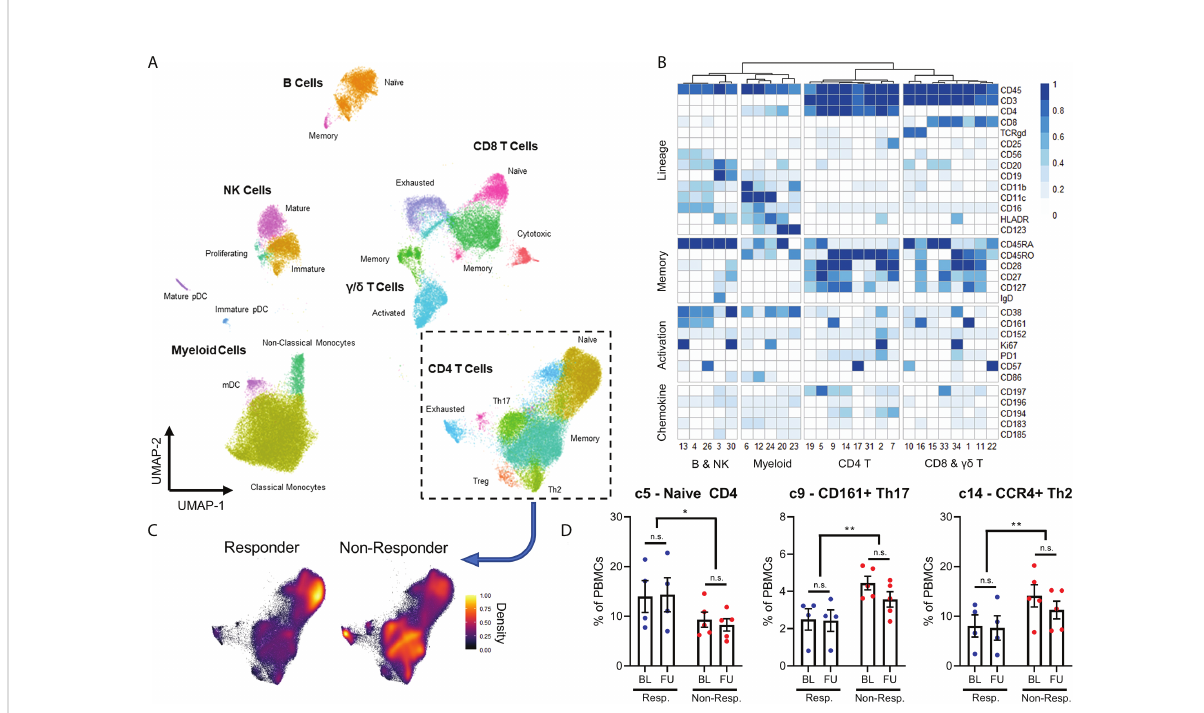
FIGURE 1 Expression patterns of 26 immune populations found in 19 samples represented through dimensional reduction (A) and heatmap (B) . Differences in density of different CD4+ T-cells populations between responders and non-responders are observed visually (C) , with responders having signi fi cantly higher proportion of naïve CD4 T-cells, lower CD161+ Th17 T-cells and CCR4+ Th2 cells seen both at baseline (BL) and at a 3-week follow-up (FU) (D) . N.S.: not signi fi cant; *p<0.05; **p<0.01.